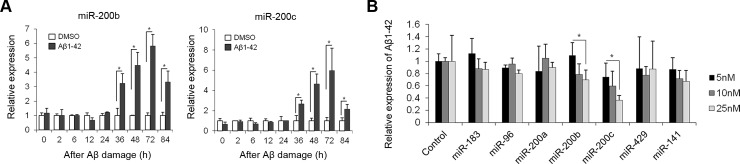
Suppressive effect of miR-200b and miR-200c on Aβ generation in vitro.(A) Aβ1–42 dramatically induced the expression of miR-200b and miR-200c in PMNCs. PMNCs were exposed to DMSO as control or 5 μM Aβ1–42 in DMSO. The results for miR-200b (left) and miR-200c (right) are shown as expression of miRNA in the treated sample relative to that of the DMSO treated control sample at each time point. *p < 0.05, n = 6. Data are expressed as mean ± standard error of the mean (SEM). (B) miR-200b and miR-200c attenuate Aβ secretion. Cells were treated with miRNAs at different concentrations (5 nM, 10 nM, and 25 nM). The Aβ1–42 secreted into the conditioned medium from neuronal cells was measured by ELISA. The results shown are relative to the levels in control transfected cells for each miRNA concentration. *p < 0.05, n = 3. Data are expressed as mean ± SEM.